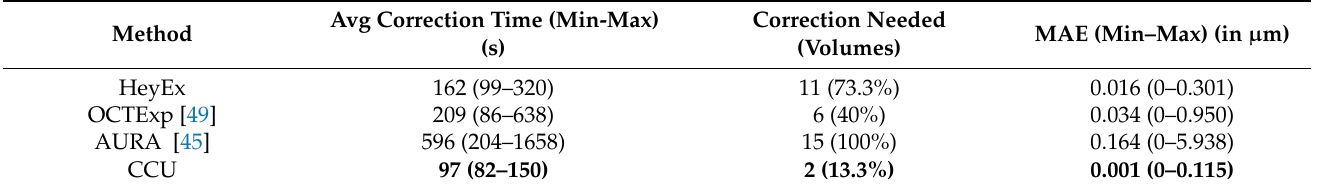
Table 10. A comparison between the proposed method (CCU, in bold) and the state-of-the-art methods in terms of the correction time (in seconds) and the deviation (in µ m) between the corrected and uncorrected versions of the selected 15 volumes. MAE: mean absolute error. The best outcomes are highlighted in